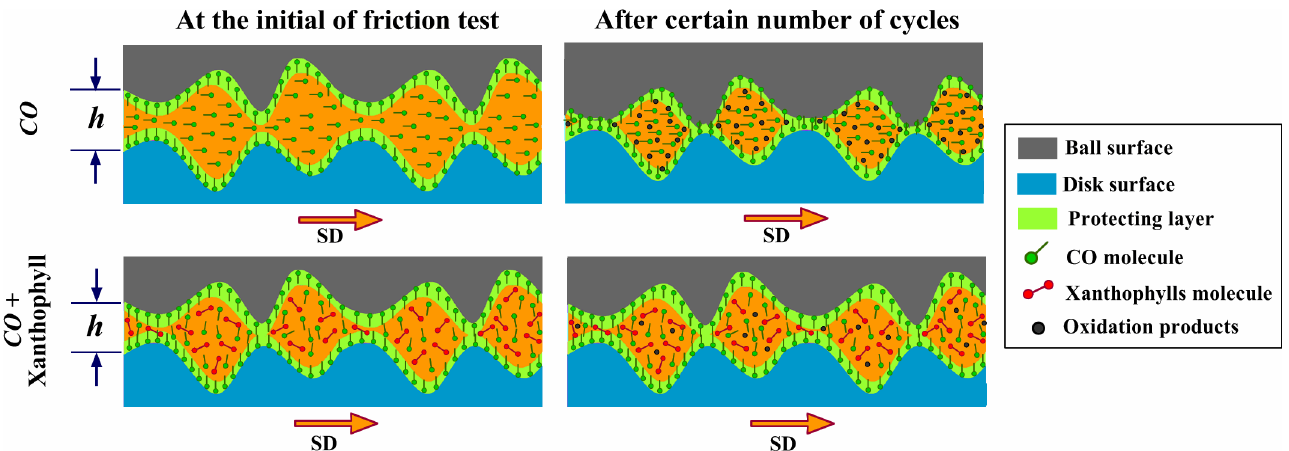
Figure 13. Schematic diagram of the friction and wear mechanism of xanthophylls as lubricant additives in CO . SD means sliding distance.